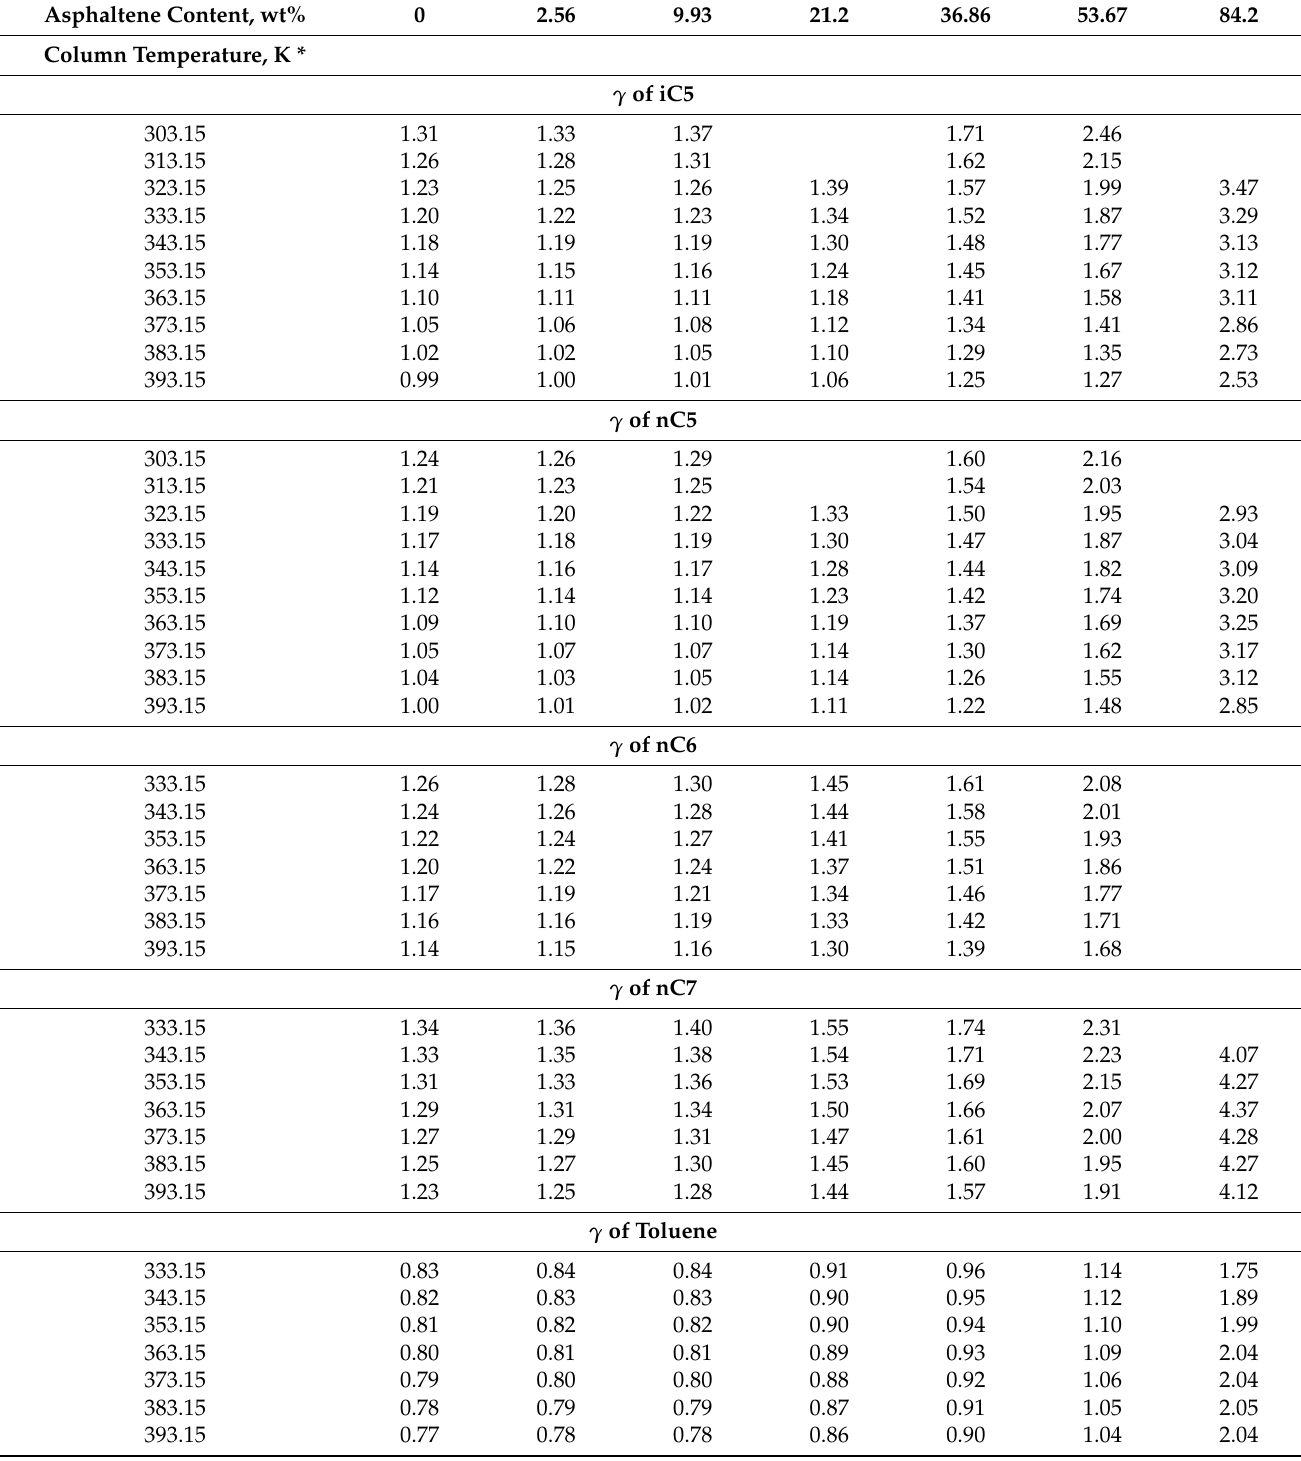
Table 4. Results of infinite dilution activity coefficients γ for investigated hydrocarbons in